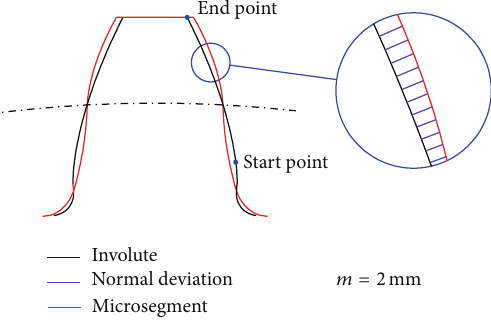
Figure 5: The geometric models for both microsegment gear and standard involute gear.